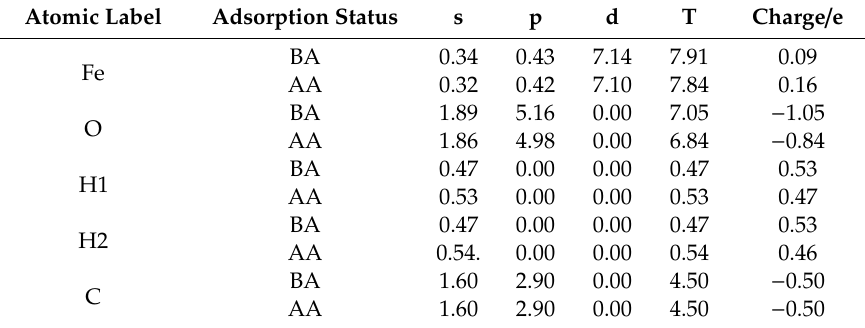
Table 7. MCP of atoms at the